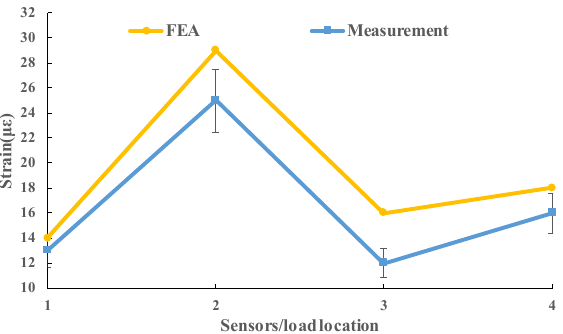
Figure 8. The results of the measurement and simulation.